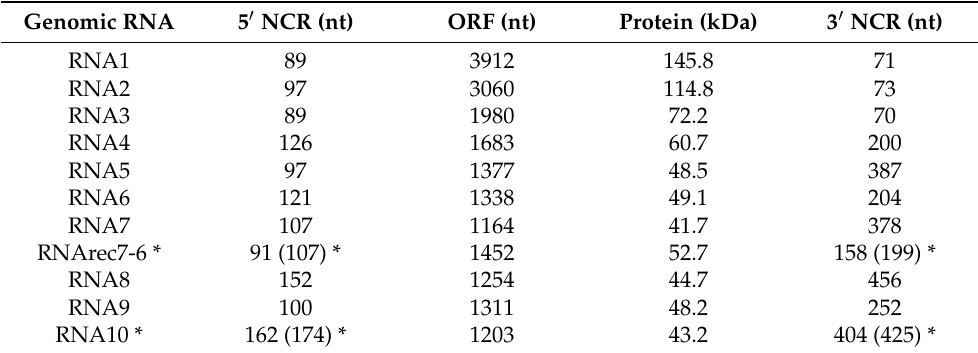
Table 2. Non-coding regions (NCRs) and ORF length and encoded proteins molecular weight for all identified genomic RNAs of